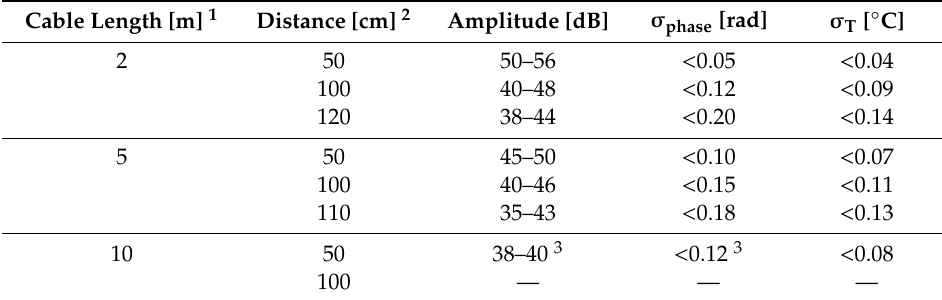
Table 2. Range measurements with S-FSCW reader, averaging = 1 and 9 dBi antennas